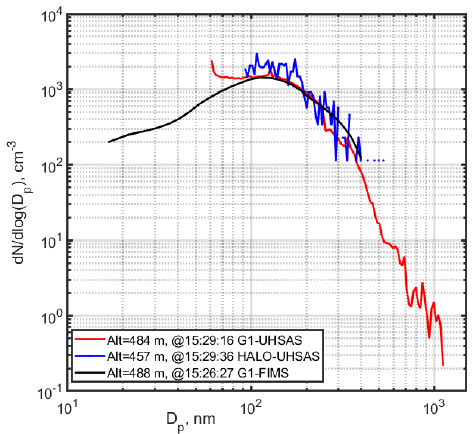
Figure 9. The G1 and HALO comparison for aerosol size distribu- tion measured by UHSAS (from both aircraft) and FIMS (on the G1) on 9